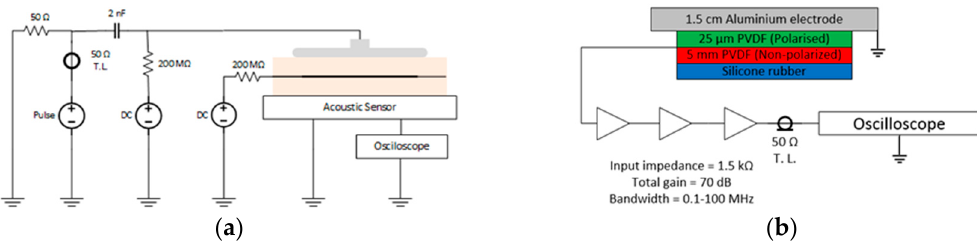
Figure 4 . Test setup for the PEA method used in the multilayer sample. ( a ) Full test system. ( b ) The construction of the acoustic sensor.